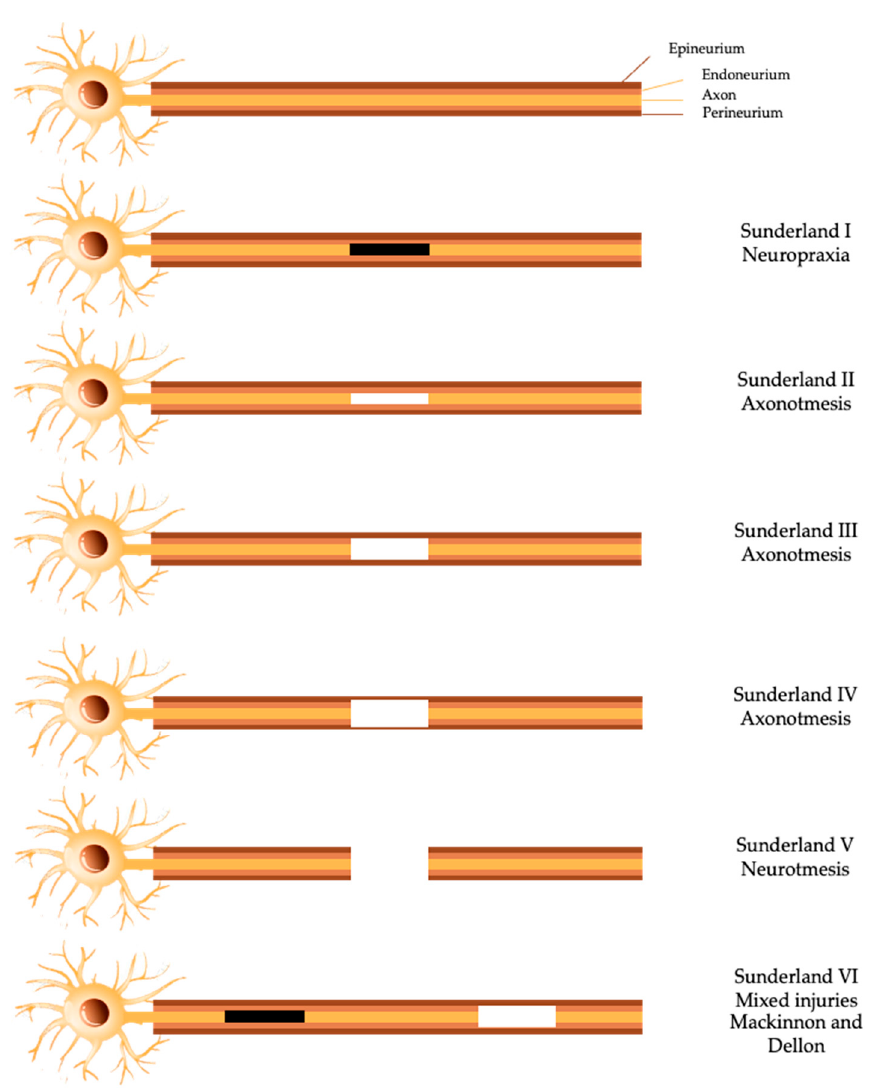
Figure 2. Schematic representation of the different injury grading systems for PNI.